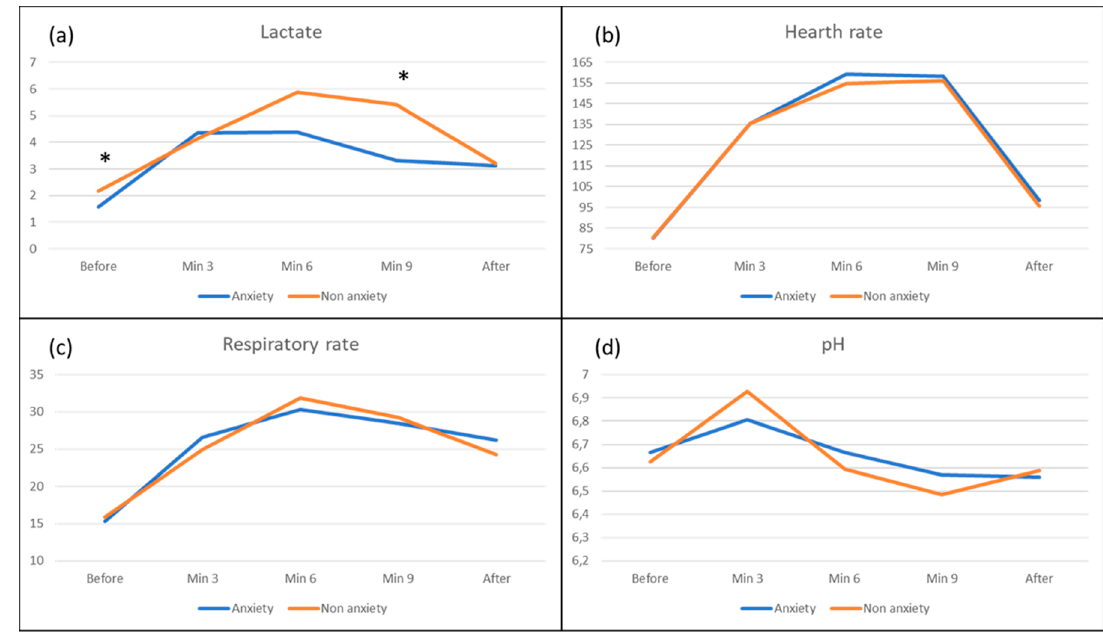
Figure 2. Physiological response during CPR according to anxiety level: ( a ) lactate; ( b ) heart rate; ( c ) respiratory rate; and ( d ) pH. * Statistically significant differences. Lactate Before ( p = 0.036), Lactate at Minute 9 ( p = 0.010).